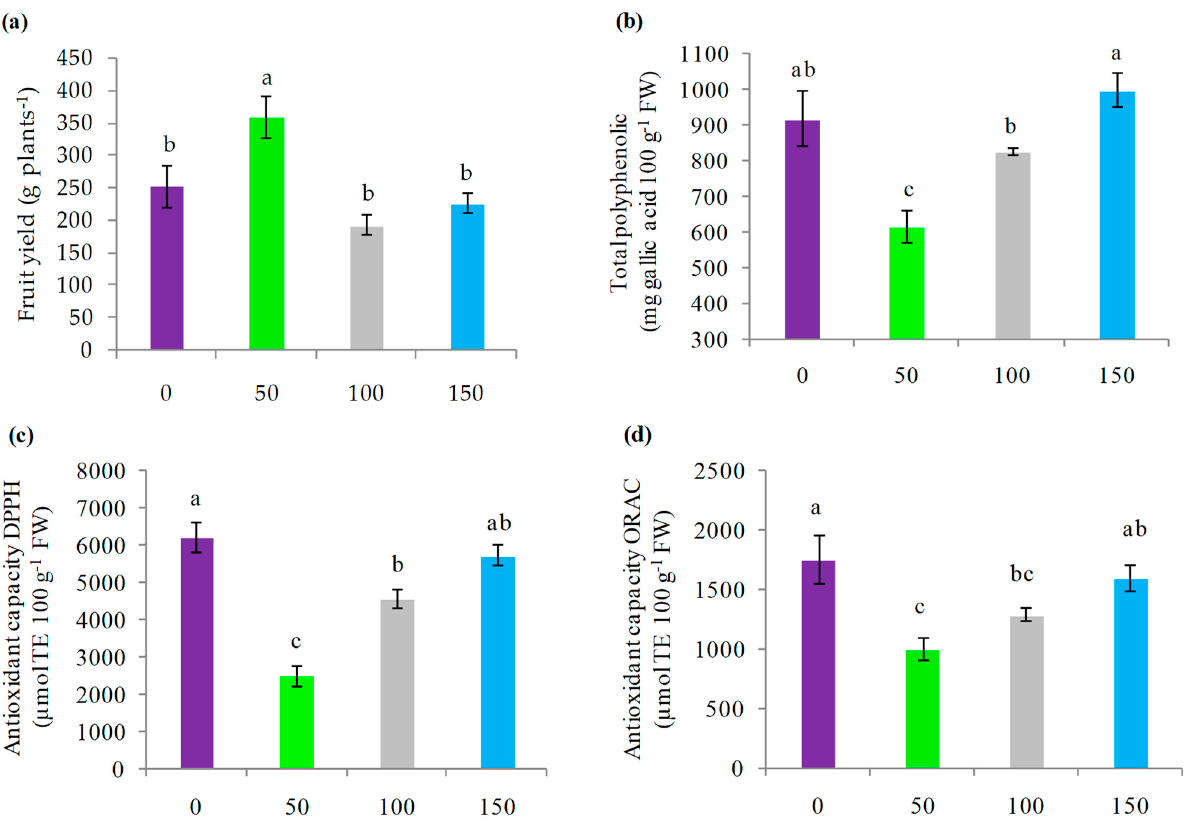
Figure 6. ( a ) Average yield of fresh fruits of calafate (g plant − 1 ); ( b ) total polyphenols; ( c ) DPPH antioxidant capacity; and ( d ) ORAC antioxidant capacity in fruits of calafate plants subjected to different doses of water replenishment. Treatments: 0%, 50%, 100% and 150% ET 0 . Different lowercase letters indicate significant differences between treatments according to Fischer’s LSD test ( p < 0.05). Mean ± standard error ( n = 4). Bars correspond to experimental error for each treatment.